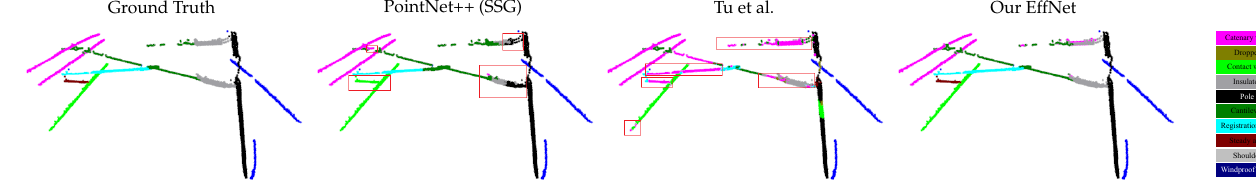
Figure 17. Evaluating the visualized